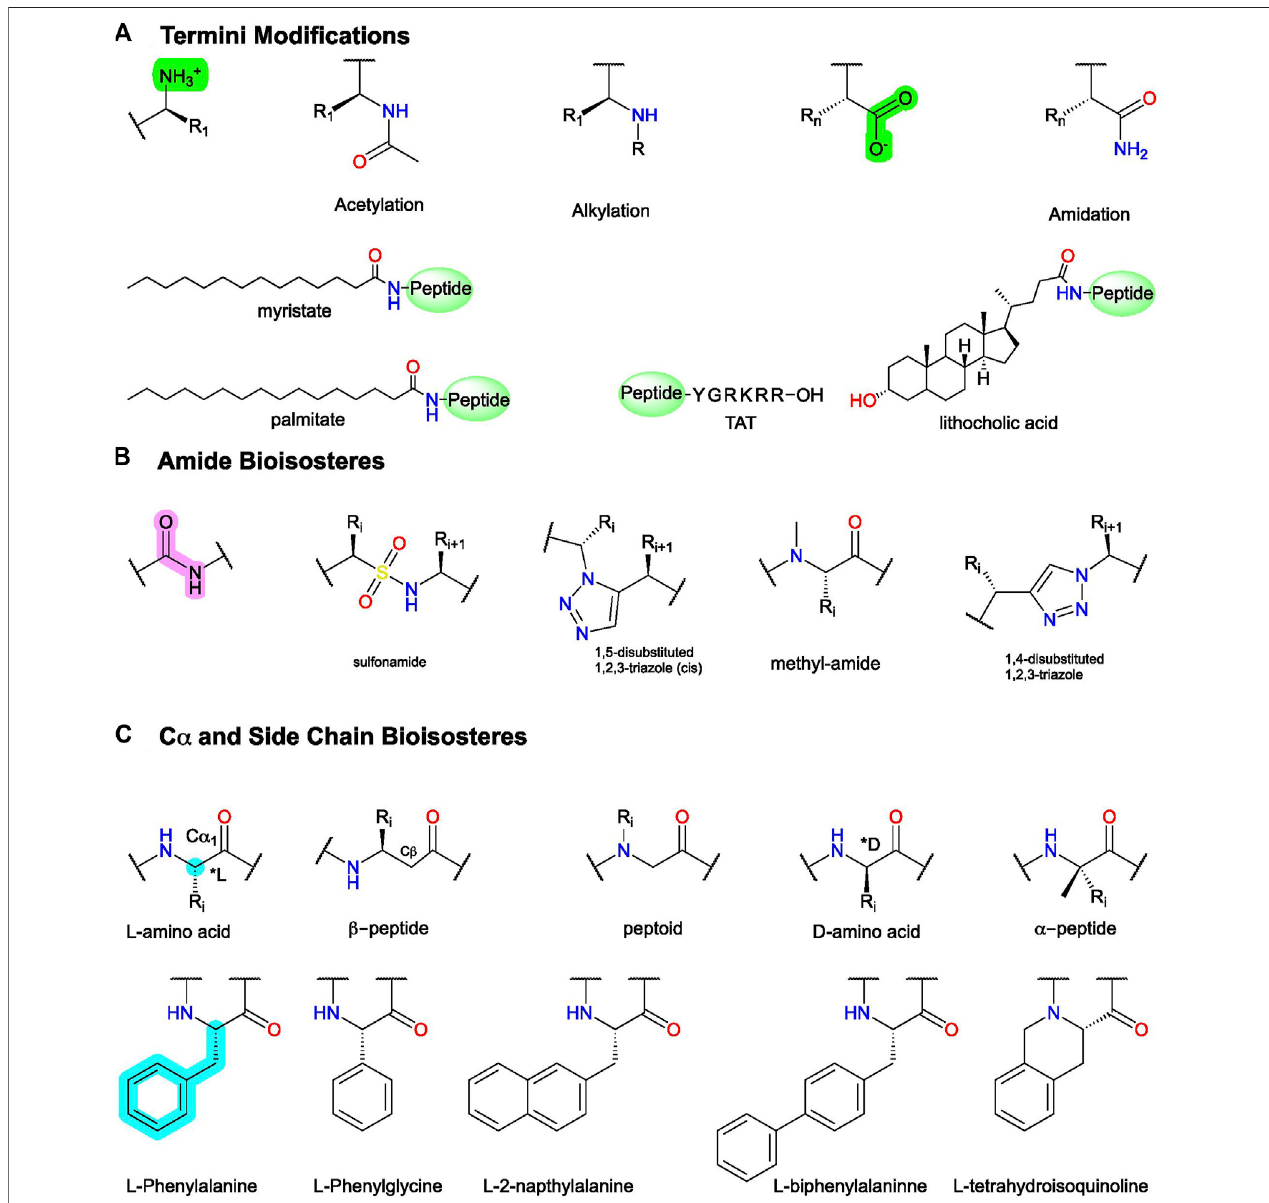
FIGURE 6 | Example peptidomimetic modi fi cations to improve activity, metabolic stability, or bioavailability of peptides. (A) Conjugation and C- and N-termini modi fi cations generally improve peptides ’ metabolic stability and bioavailability. (B) Amide bioisosteres replicate the electronic and physiochemical properties of the amide bond (pink). (C) (Top) example modi fi cations to C α and (bottom) sidechain isosteres of phenylalanine (F). Figure was created with Chemdraw20.0.